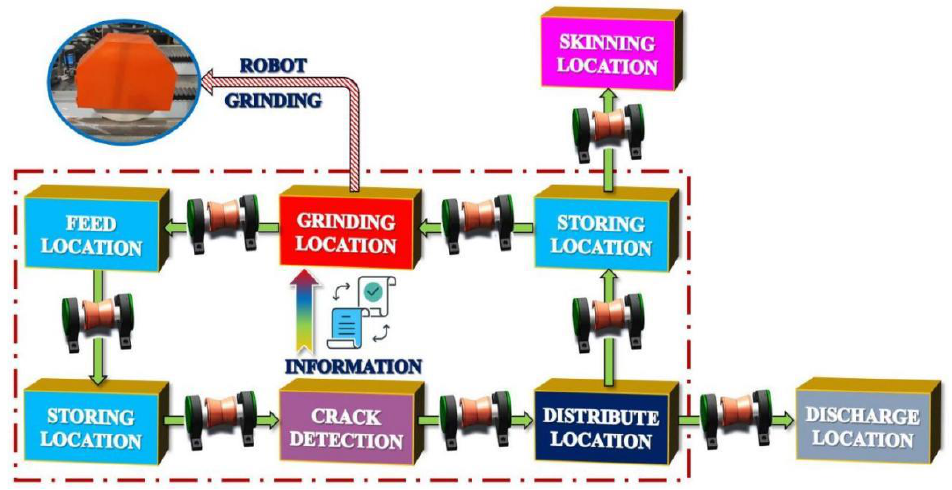
Figure 2. Online finishing process of the steel bar.